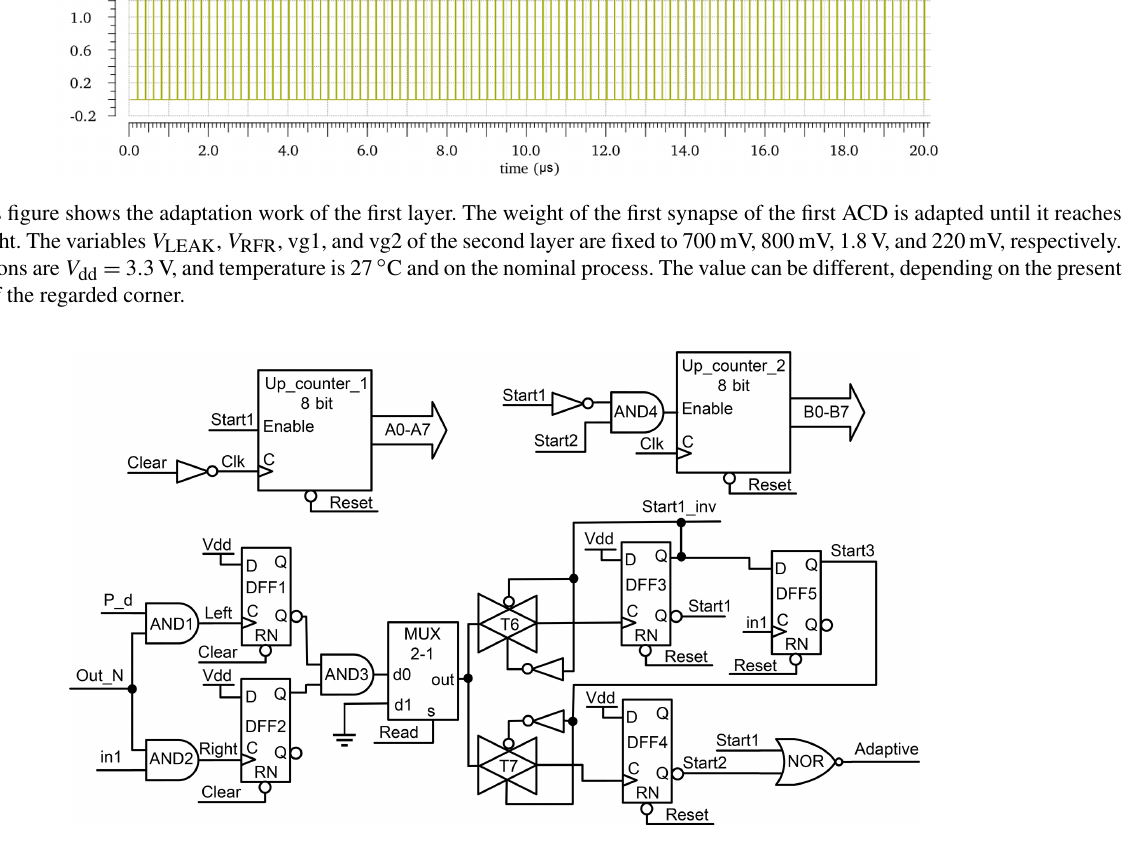
Figure 9. The control circuit of adaptive coincidence detection (ACD). It implements the self-adaptive method for the synapses’ weights and saves the synapses’ weights on the